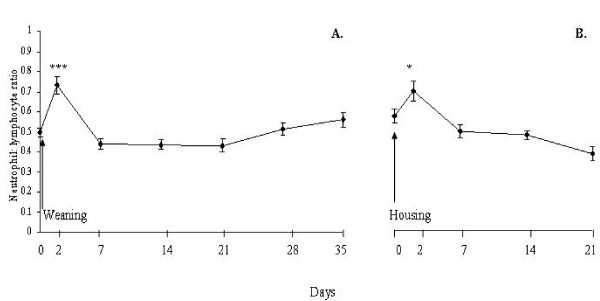
Effect of abrupt weaning and subsequent housing on neutrophil: lymphocyte ratio in beef cows. Significant differences between d 0 (pre-weaning) and d 35 baselines (pre-housing) are denoted by asterisks; * = P < 0.05 and *** P < 0.001